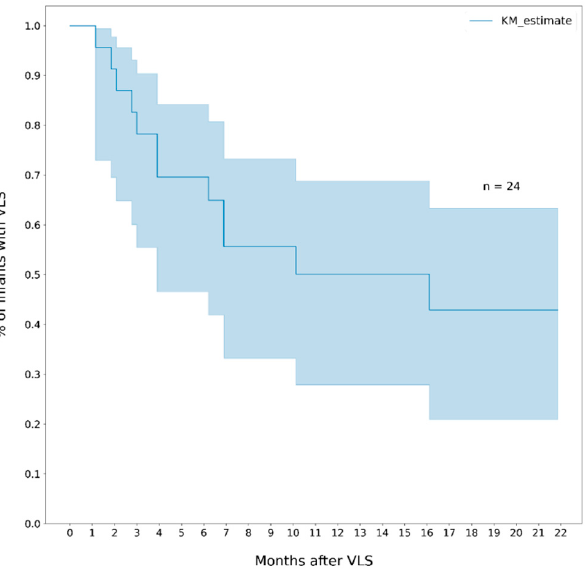
Figure 3. Cumulative probability of viral rebound (VL > 1000 cp/mL) among infants who reached viral suppression (VL ≤ 400 copies/mL). Note. The area in blue represents the 95% CI.